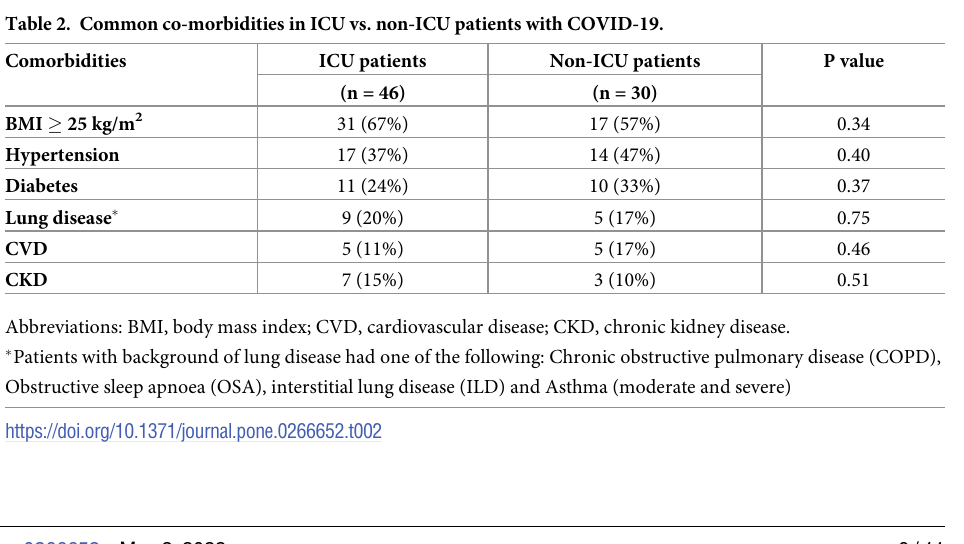
spectrum antibiotics and in total nine (19%) were on adjunctive anti-fungal treatment (25% in normal PCT group and 15% in high PCT group). Forty eight percent of patients in ICU had positive culture for bacterial growth within 48 hours from PCT and cytokine requests com- pared to 10% in the non-ICU group. Out of all positive cultures, 84% were respiratory samples (sputum, bronchial washing and bronchoalveolar lavage), 8% were blood samples and 8% were urine samples. The most common pathogens identified from cultures were Gram Table 2. Common co-morbidities in ICU vs. non-ICU patients with COVID-19.